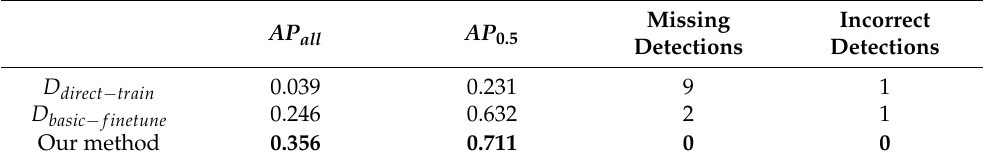
Table 3. Average precision and number of wrong detections (the best results are marked in